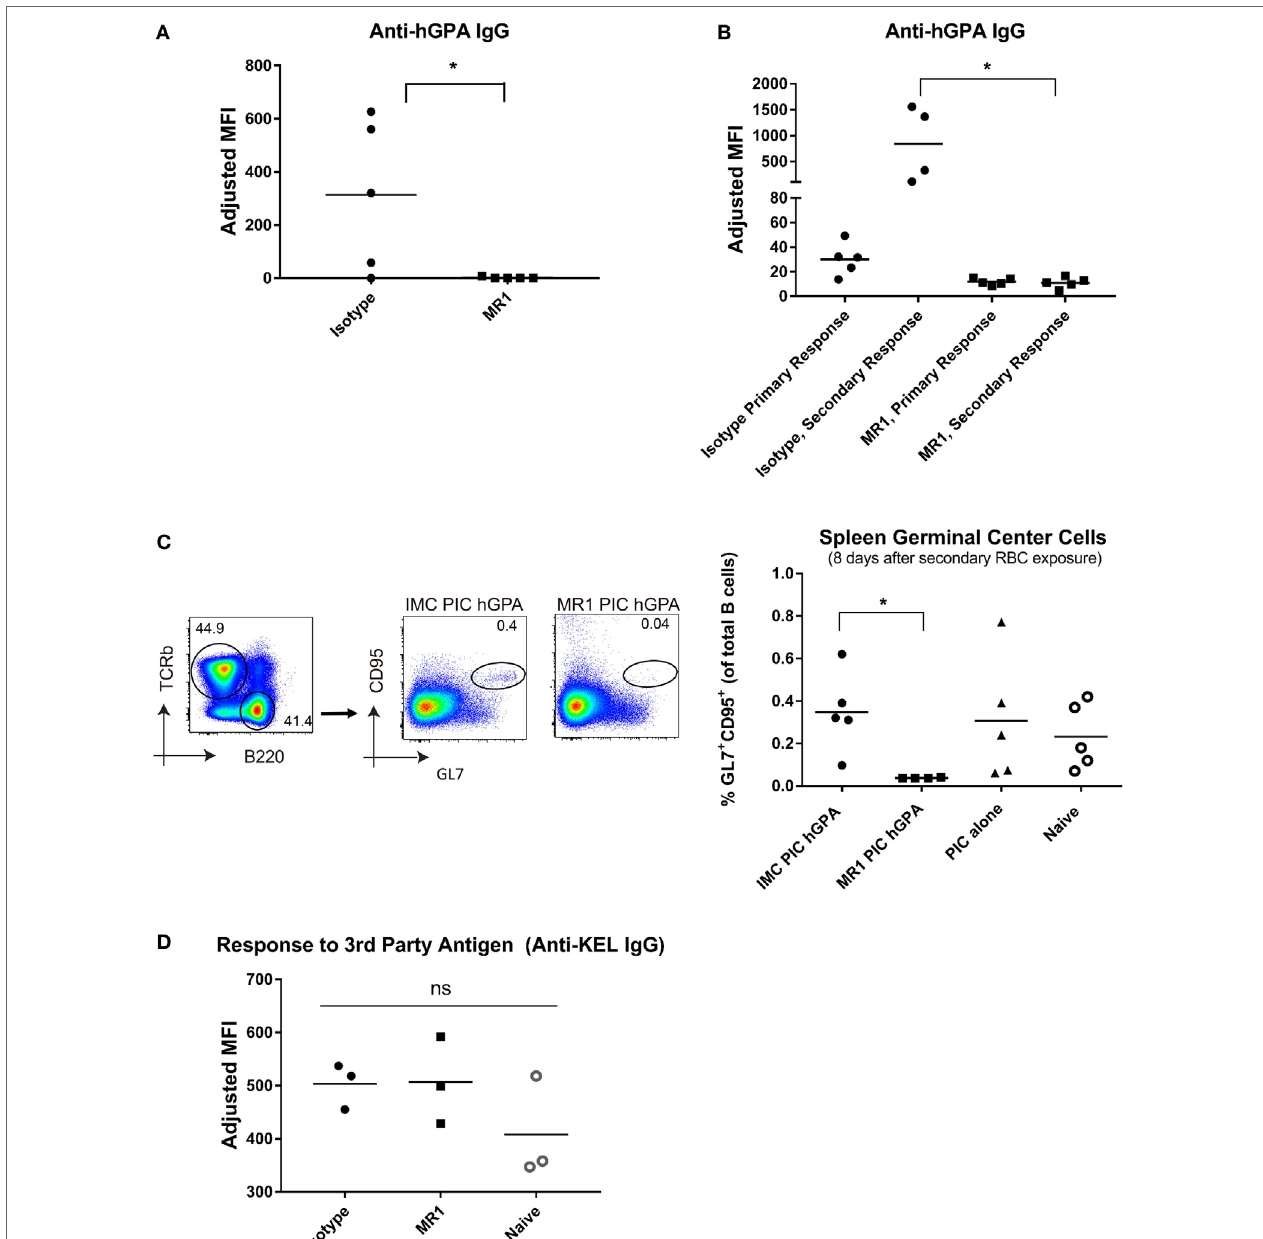
FigUre 3 | Alloimmunization to human glycophorin A (hGPA) RBCs is abrogated upon blocking CD40L, a co-stimulatory molecule. (a) Serum anti-hGPA IgG at day 14 post-transfusion represented as adjusted mean fluorescence intensity (MFI) in mice treated with MR1 or isotype antibody during primary transfusion. (B) Serum anti-hGPA IgG after primary transfusion (7 days before secondary transfusion) and 14 days after secondary transfusion. (c) Splenic germinal centers (GL7 + CD95 + B-cells) 8 days after secondary RBC exposure. (D) Serum anti-KEL IgG after primary KEL transfusion in naïve animals or in those previously treated with MR1 or isotype-matched control antibody during prior hGPA transfusion. * p < 0.05 determined by Mann–Whitney U test or ANOVA. Data are representative of at least two experiments ( n = 3–5 mice per group per